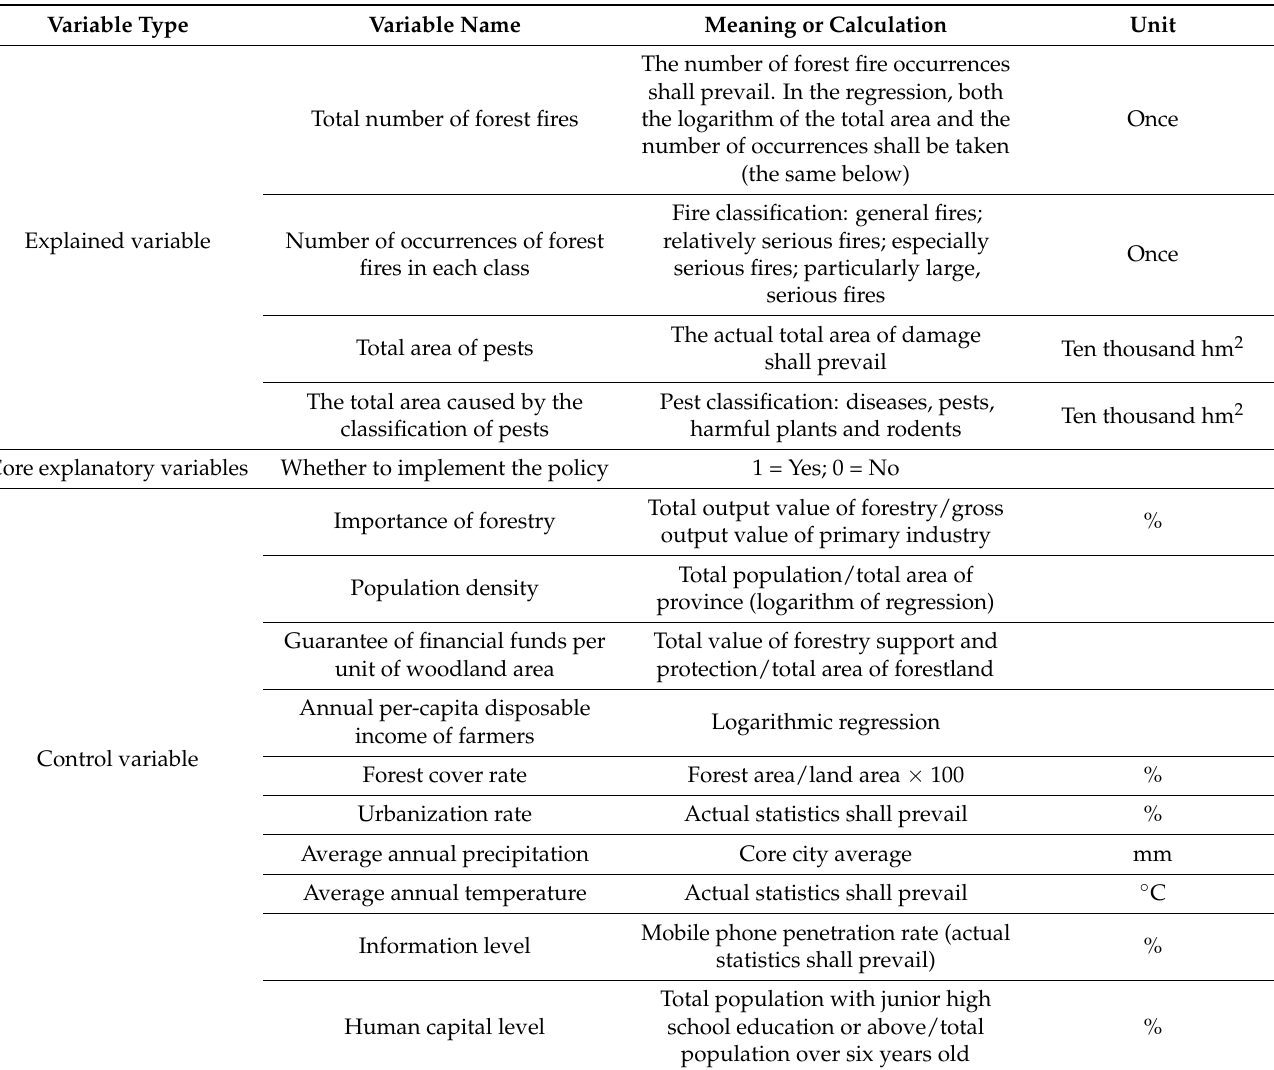
Table 1. Variable meanings and assignment